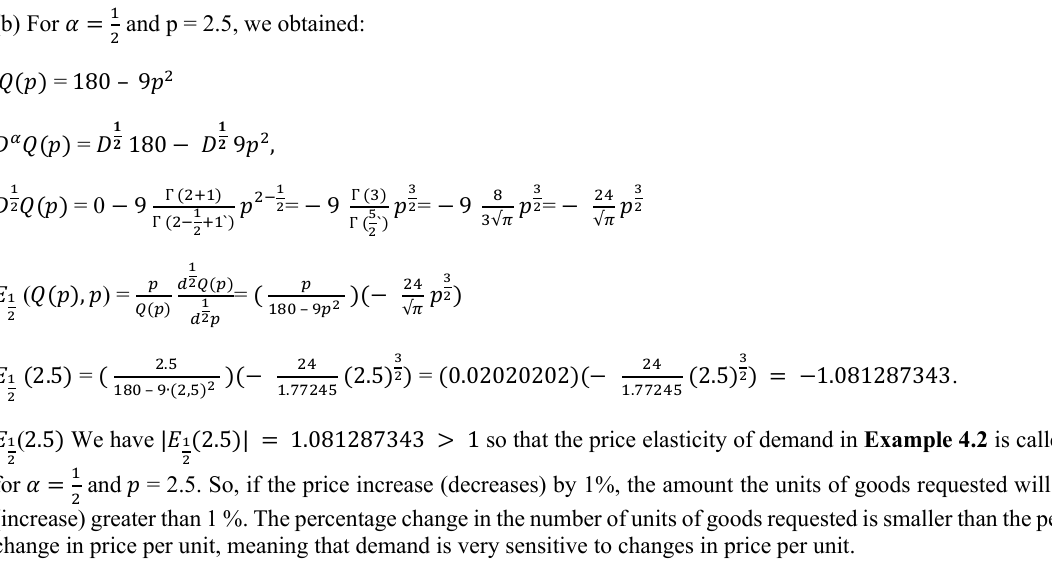
= 0 and 𝑘 (cid:2869)